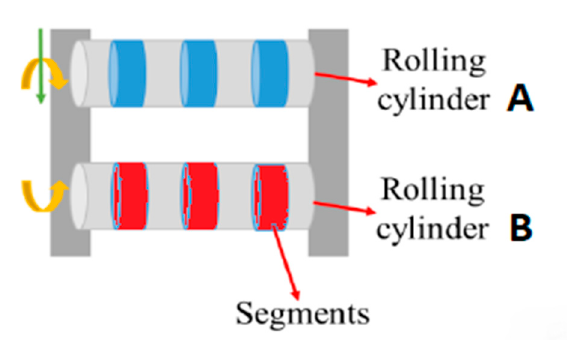
Figure 1. Industrial rolling mill with three segments at their end of operational life (red color) on cylinder B and three new (blue color). Cylinder A can move linearly in the vertical direction.